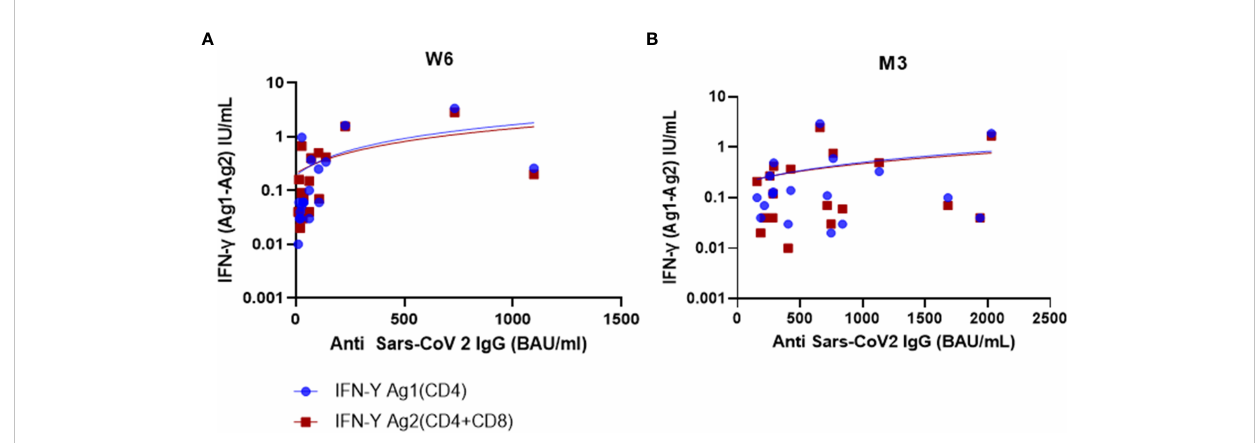
FIGURE 3 Humoral and cellular response correlation at W6 and M3. (A) At W6, there was a strong positive correlation between IFN- g Ag1(CD4) and SARS-CoV- 2 IgG (BAU/mL) ( r =0.73; p<0.001) but a moderate positive correlation between IFN- g Ag2(CD4/CD8) and SARS-CoV-2 IgG ( r =0.63; p=0.004). (B) At M3, there was a weak positive correlation for both IFN- g (Ag1 and Ag2), and SARS-CoV-2 IgG ( r =0.12; p=0.639) ( r =0.27; p=0.284), respectively. Test: Spearman correlation